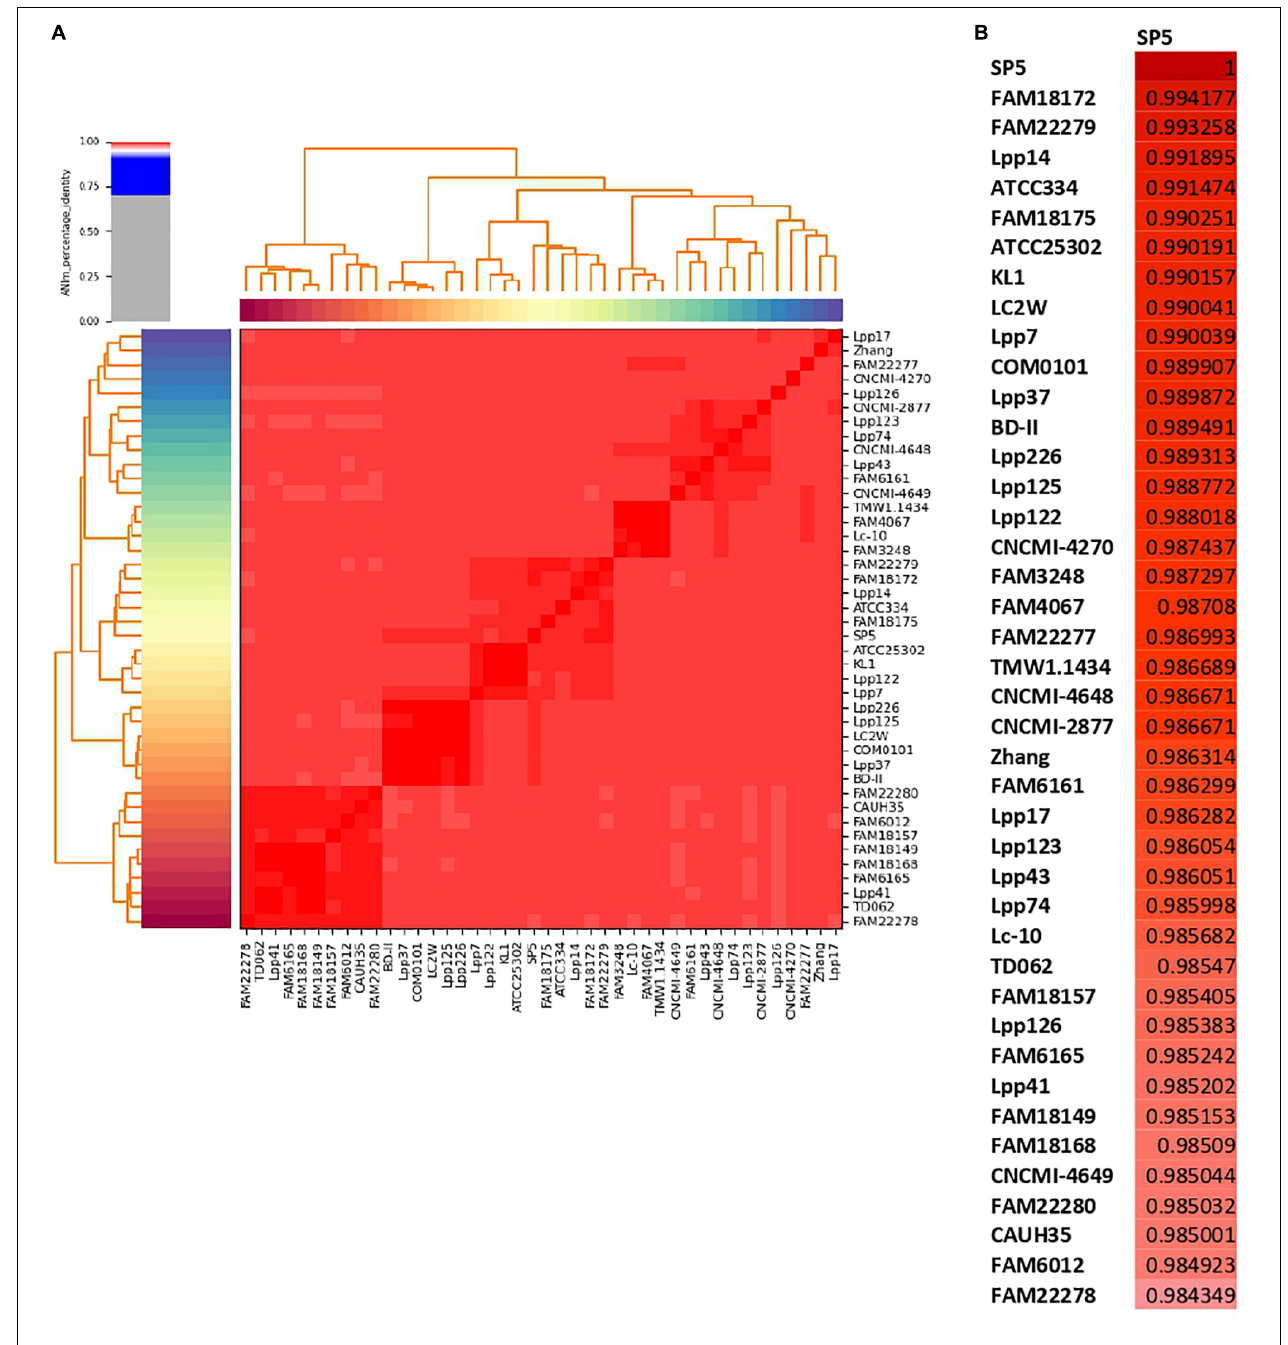
FIGURE 3 | ANI of Lc. paracasei strains derived from fermented milk products estimated using Pyani (version 0.2.10). (A) ANI heatmap of all dairy isolates, (B) ANI of Lc. paracasei SP5 with dairy